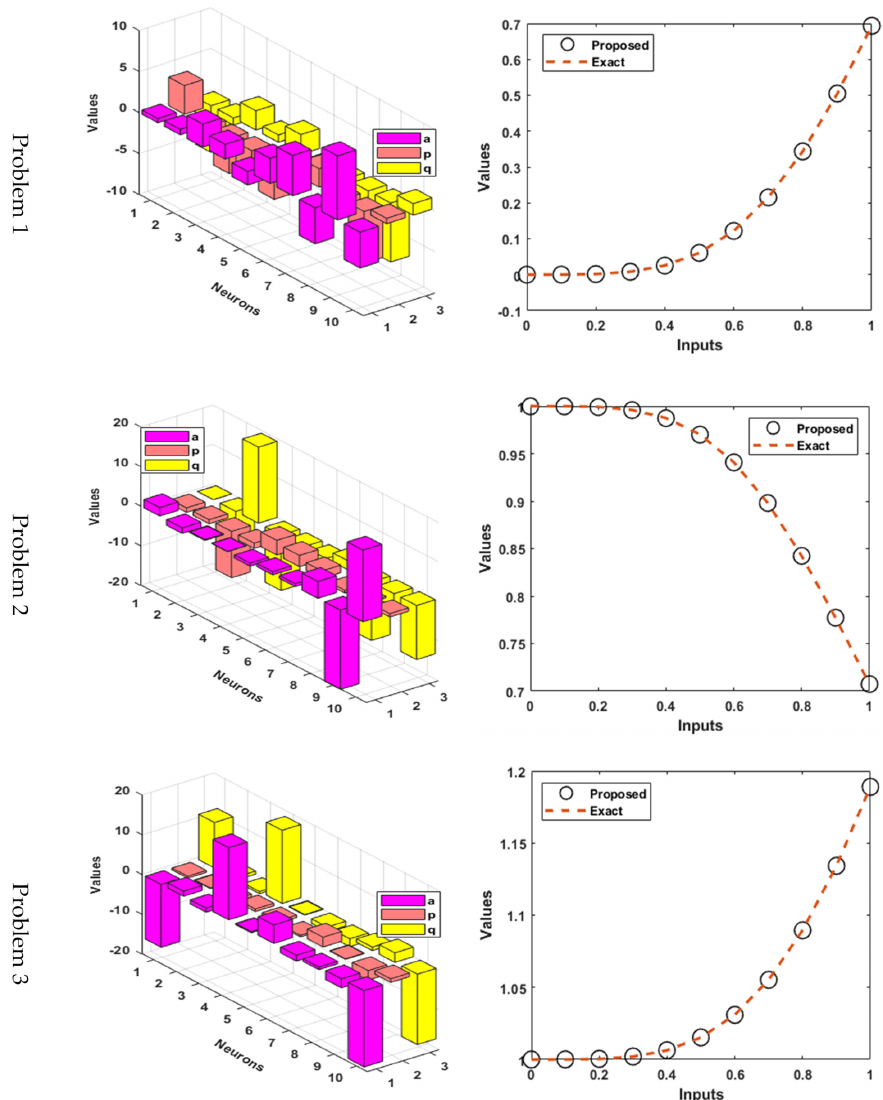
Figure 2. Comparison of best weights and results for each problem of the HO-NSDM.